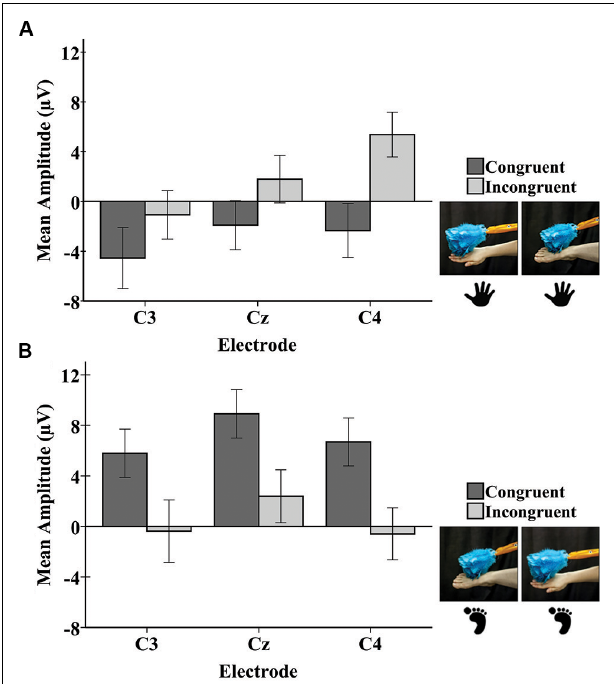
FIGURE 5 | Mean amplitudes of the late potential in the SEP response at each electrode to tactile stimulation of the infant right hand (A) and the infant right foot (B) . Hand and foot icons indicate the infant body part receiving tactile stimulation. Photographs depict the live visual event observed by the infants. Error bars represent ± 1 standard